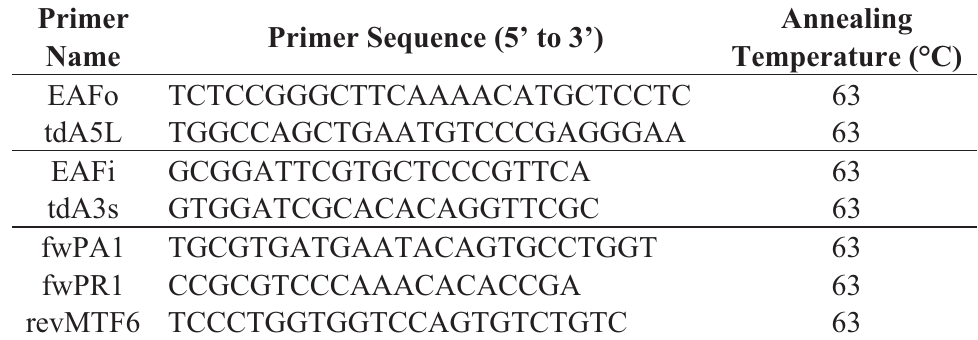
Table 3. Primers utilized for amplification of CENP-A gene from Percina